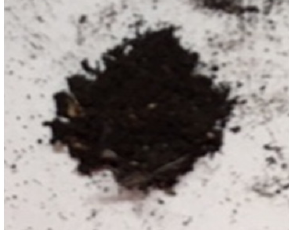
Figure 2. An example of chimney deposit (soot) sample collected from the inner surface of the chim- ney. In order to obtain access to the deposit, the second part of the chimney device was separated from the whole chimney system, and then soot samples were collected at selected heights using a spoon for the lower levels and an elongated brush tool for the higher levels.